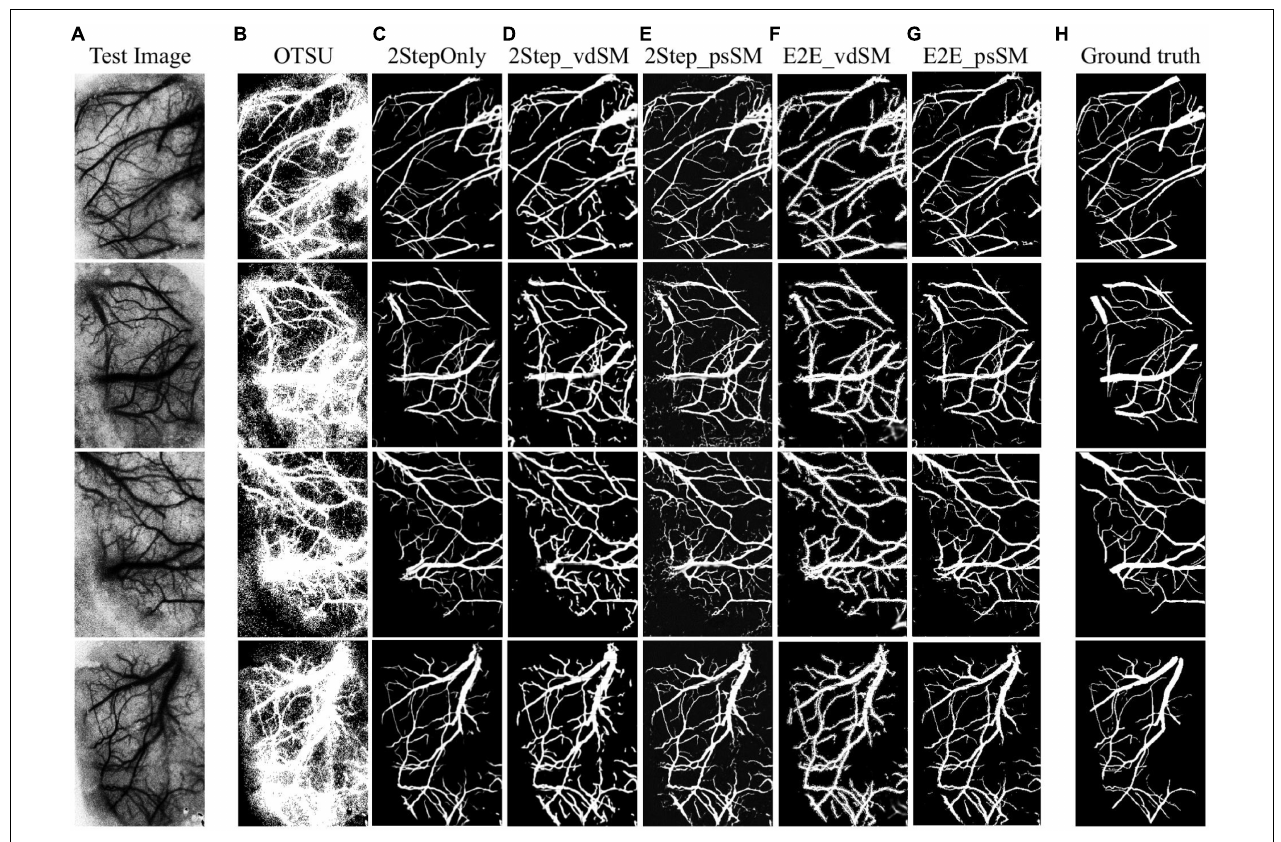
FIGURE 7 | Examples of laser speckle contrast image segmentation. (A) Raw images. Segmentation results from: (B) OTSU’s threshold segmentation, (C) two-stage training without size matching, (D) two-stage training with vdSM, (E) two-stage training with psSM, (F) end-to-end training with vdSM, and (G) end-to-end training with psSM. (H) Ground truth. TABLE 1 | Quantitative evaluation results for the testing images.